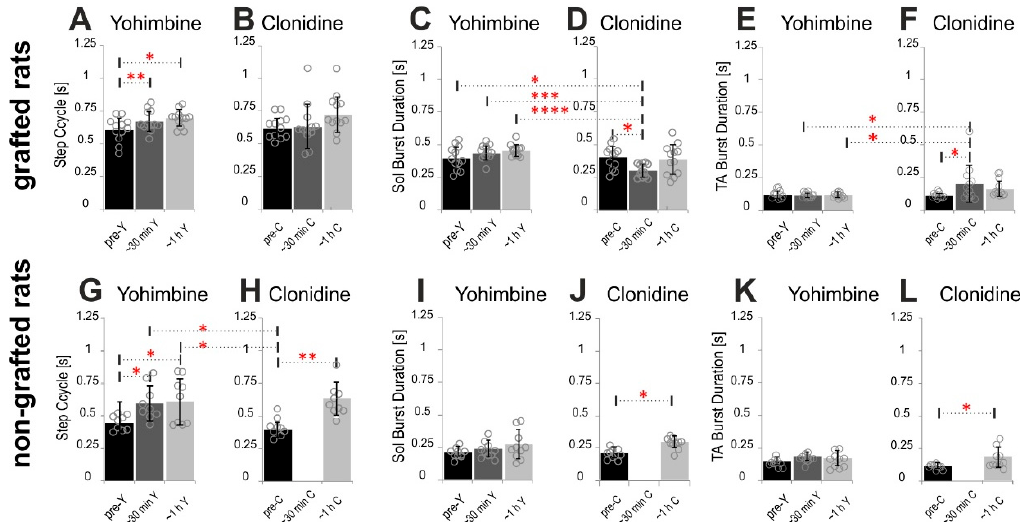
Figure 7. The cycle duration and EMG burst duration of the Sol and TA muscles before and after yohimbine or clonidine aplications in spinal grafted ( n = 6) rats ( A – F ) and non-grafted ( n = 5) spinal ( G – L ) rats as well as before and after clonidine in grafted ( D – F ) and non-grafted ( J – L ) spinal rats. The bars represent means ± SD established for the two groups of rats (with and without a graft) in various experimental conditions, while gray circles present the data from individual rats. RM ANOVA with Tukey’s multiple comparisons test : * p < 0.05; ** p < 0.01;*** p < 0.001; **** p < 0.0001. Abbreviations: Sol: soleus muscle; TA: tibialis anterior muscle; ~30 min: < 30 min after drug application; ~1 h: one hour after drug application; C: clonidine; Y: